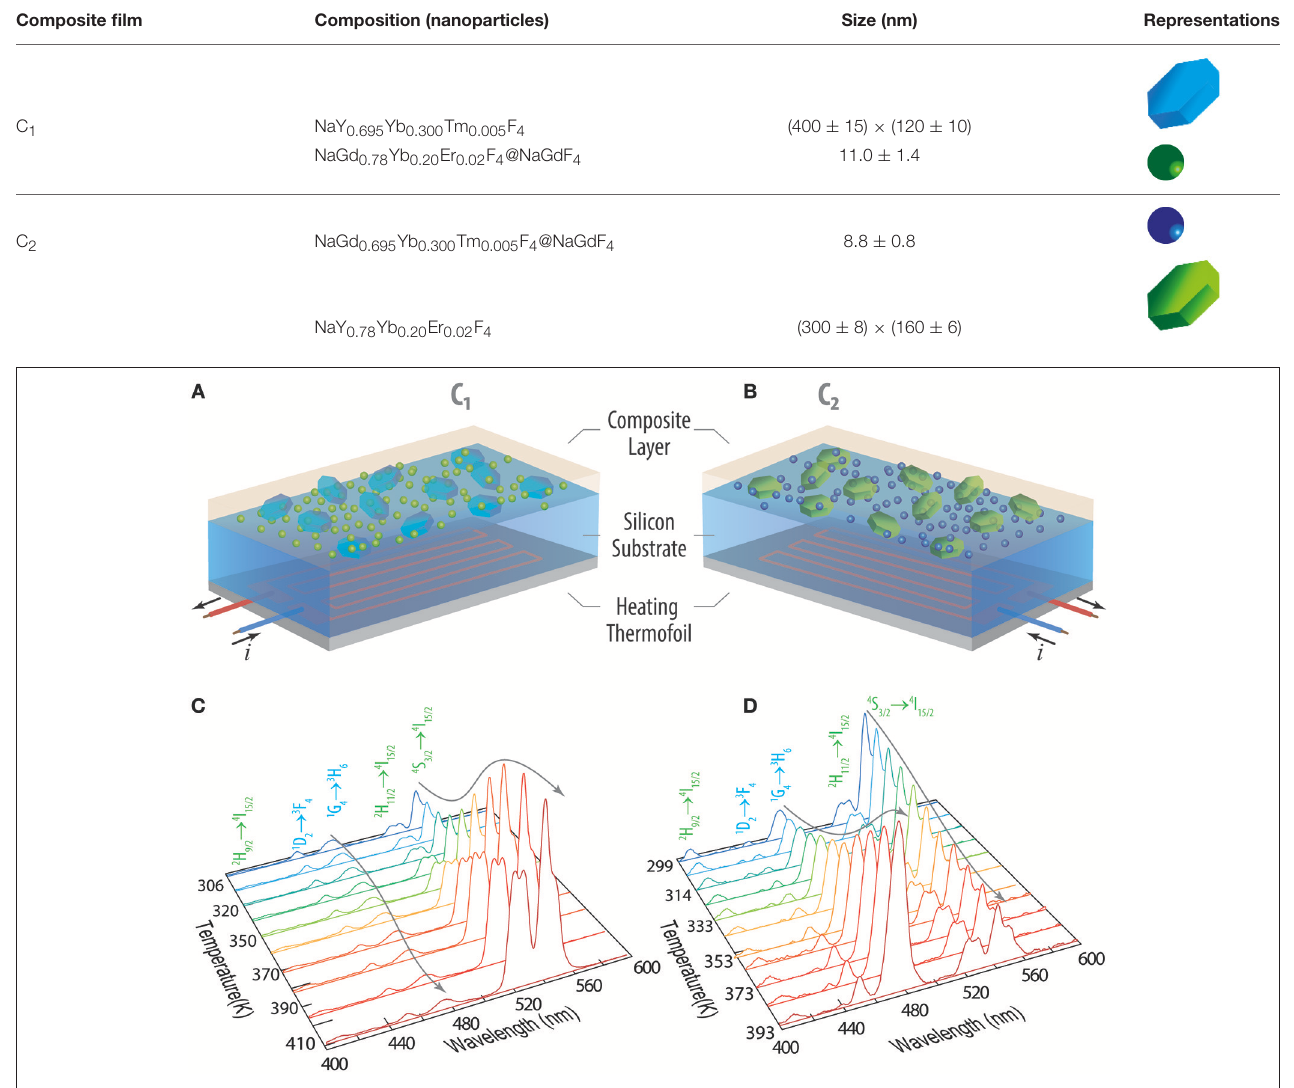
FIGURE 1 | Schematic representation of the nanocomposites (A) C 1 and (B) C 2 . The electrical current flowing in the heating thermofoil is used to control the local temperature of the UCNPs in the composite layer. The temperature dependent emission spectra upon 980nm excitation is presented for (C) C 1 and (D) C 2 within the 299–410K range. The Er 3 + and Tm 3 + transitions are depicted in green and blue,